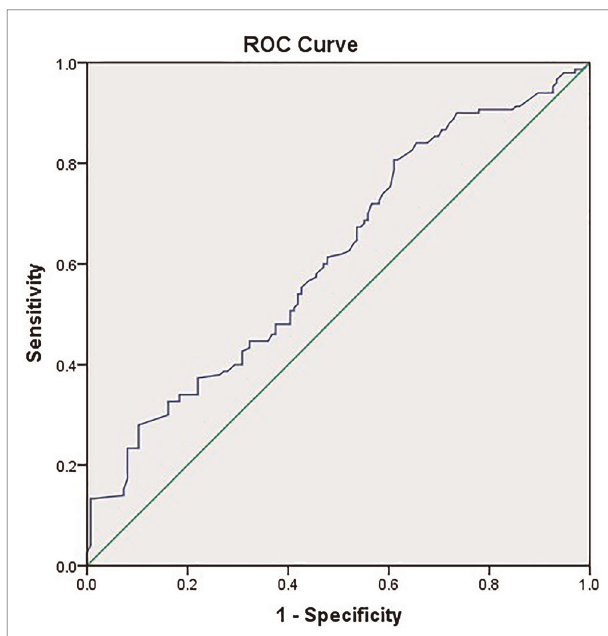
FIGURE 3 | Receiver operating characteristic (ROC) curve for threshold analysis of predicting PPAP (AUC